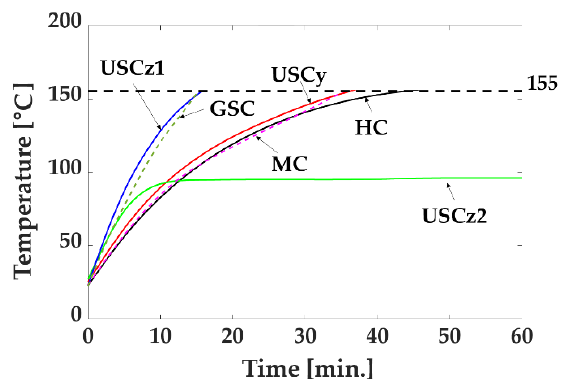
Figure 8. Temperature rise of coils for elapsed time.